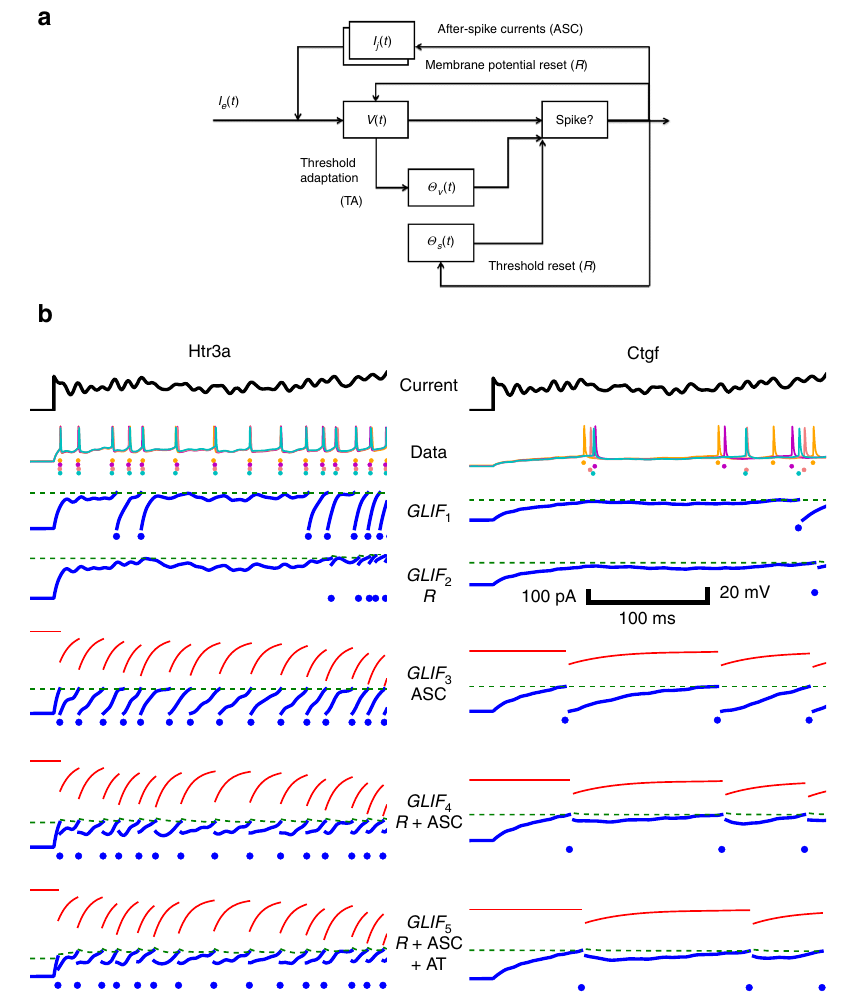
Fig. 1 Five generalized leaky integrate-and- fi re (GLIF) models consisting of different phenomenological mechanisms are fi t to electrophysiological data. A schematic describing the mechanisms is shown in a . Example data and models from two neurons of different transgenic lines are shown in b . For all models the input is a current, I e ð t Þ , injected via a patch electrode illustrated in black at the top of b . Below the current are the voltage traces from four repeats of the same stimulus (here colors represent the different responses to the repeated stimuli and do not adhere to the standard color scheme in the rest of the manuscript). Below the biological data, the GLIF models are plotted. The output of the models is the trans-membrane potential, V ð t Þ , pictured in blue. When V ð t Þ reaches a threshold, Θ ¼ Θ 1 þ Θ S ð t Þ þ Θ v ð t Þ , shown in dashed green, a spike is produced, illustrated by blue dots. Note that the shape of the spike is not plotted as it is not fi t by these models. Instead, after a refractory period, V ð t Þ is reset to a value dependent on the speci fi c model. The GLIF 1 model is equivalent to the traditional LIF model with a refractory period where the model can not spike. This model contains one variable, V ð t Þ , and the threshold is fi xed to a value we refer to as Θ ∞ . GLIF 2 models include a second variable: a spike-induced threshold Θ S ð t Þ which is added to the baseline threshold Θ ∞ . When the model spikes, Θ S ð t Þ , jumps up and then decays. Thus, after a spike, initially the total threshold is higher making it harder for the model to reach threshold. GLIF 3 includes V ð t Þ and two variables corresponding to two spike initiated after spike currents, I j ð t Þ , which have different time constants and decay back to zero. The sum of the after-spike currents are illustrated in red. GLIF 4 combines GLIF 2 and GLIF 3 for a total of four variables.